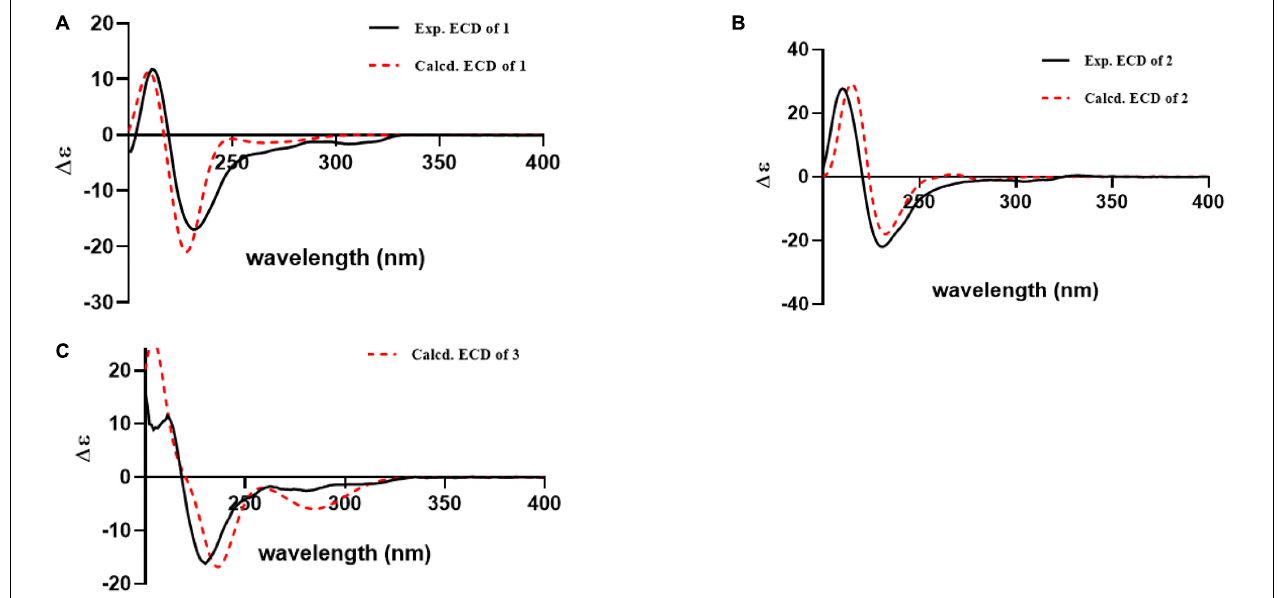
FIGURE 4 | Experimental and calculated ECD curves for compound 1 (A) ; compound 2 (B) ; compound 3 (C) .